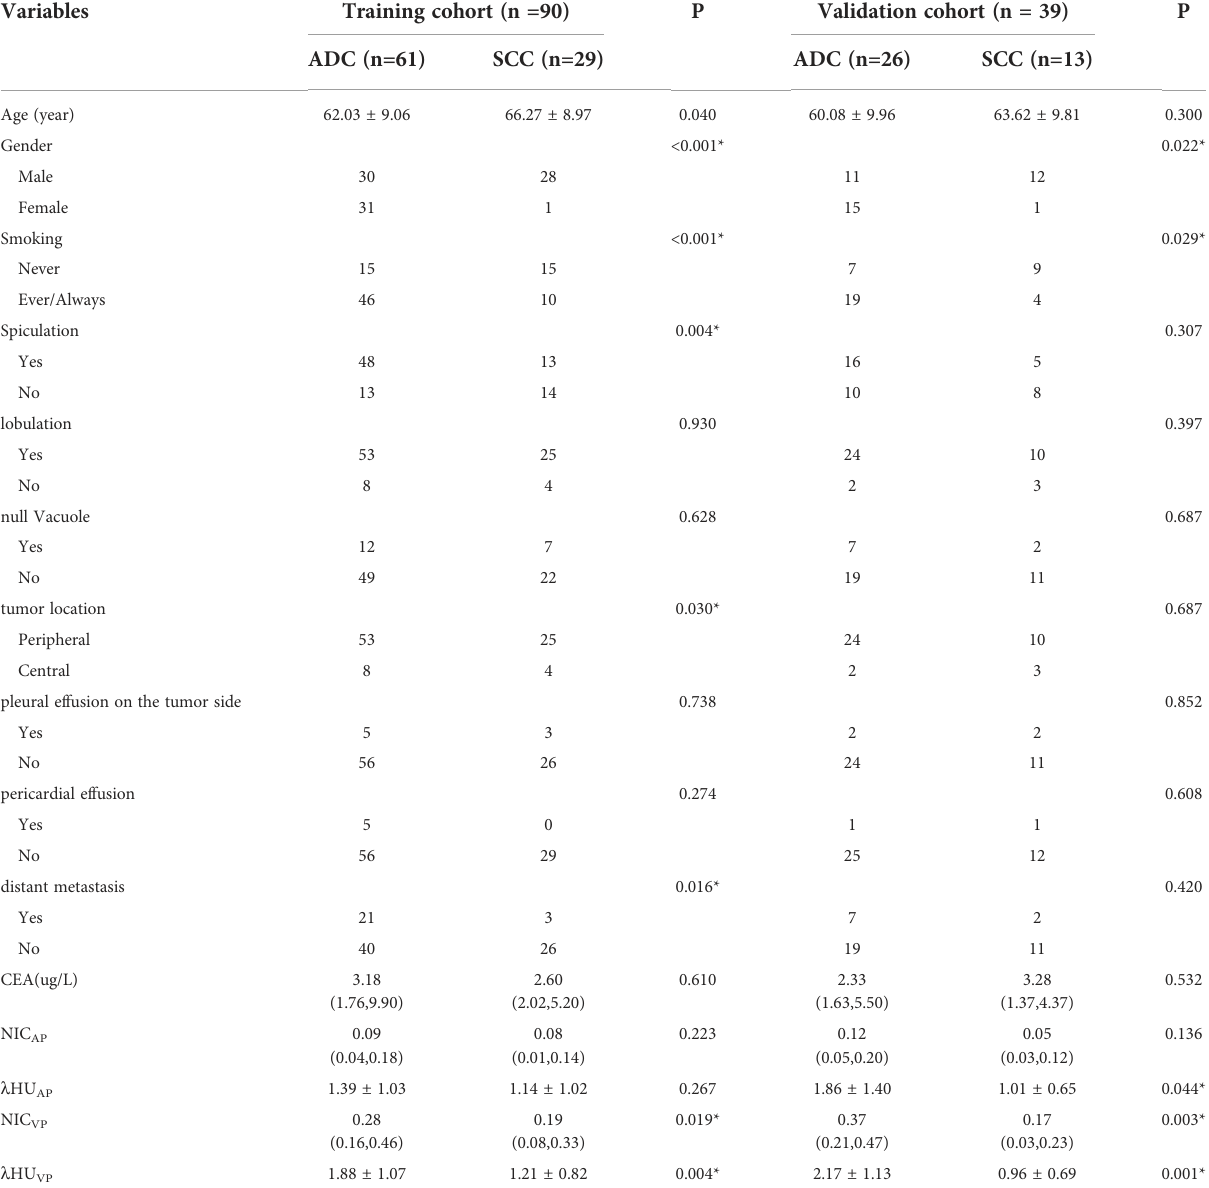
TABLE 1 Clinical parameters of